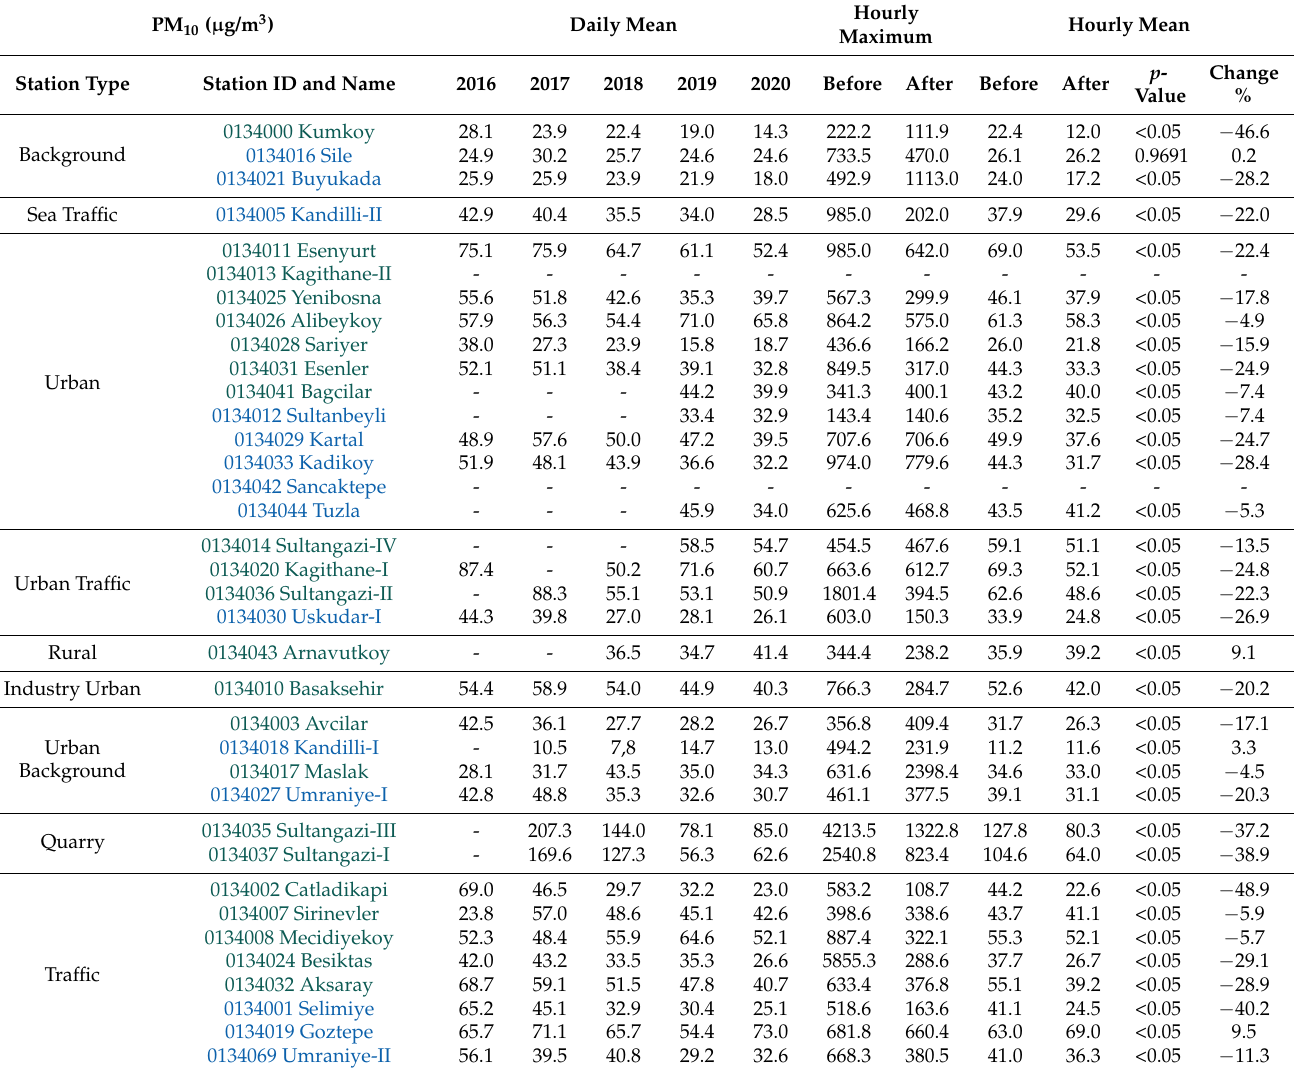
Table 1. Preceding-term analysis of PM 10 . Blue names indicate Anatolian Side, Green names is for stations located in the European